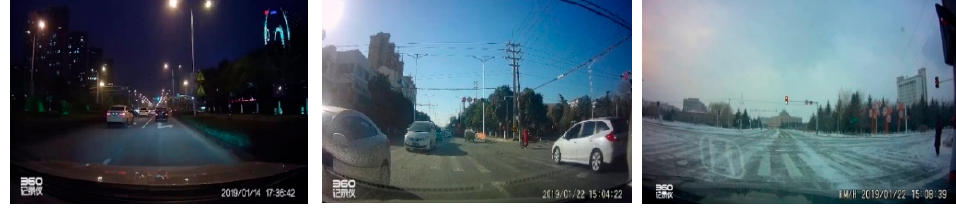
Figure 7. Some samples in the Pascal VOC and CCTSDB2021 datasets.